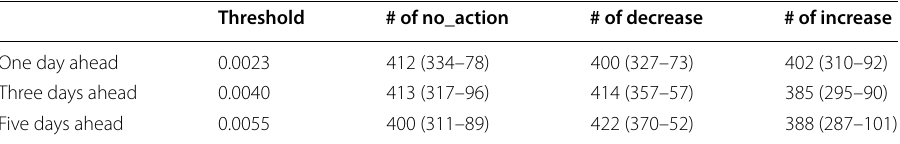
Table 3 Data set statistics (training and test